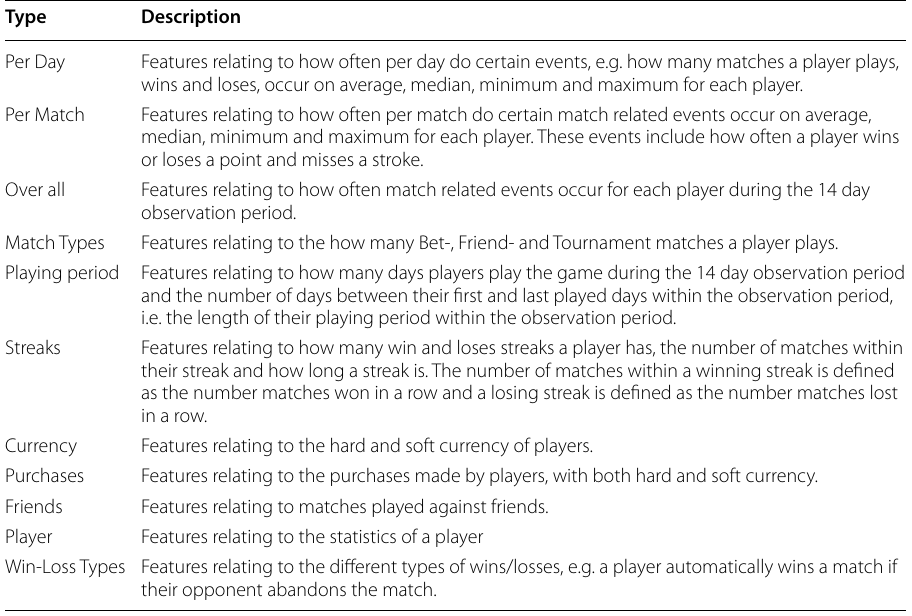
Table 1 Description of feature categories among the benchmark features